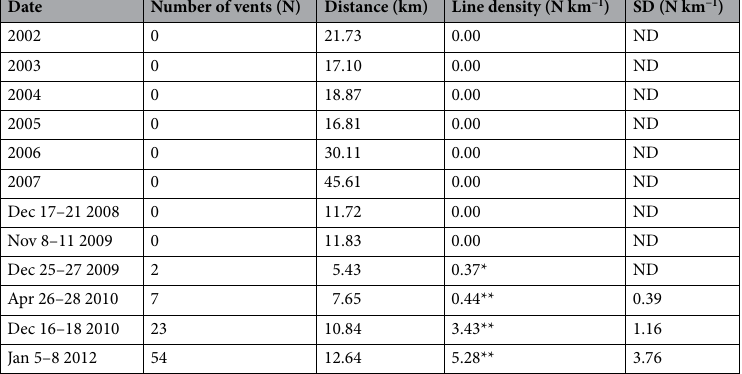
Table 1. Number of vents detected by AUV “Tantan”, its cruising distance and unit distance density of vents from 2002 to 2012. *Indicates number of vents over distance. **Evaluated from linear regression on number of vents against